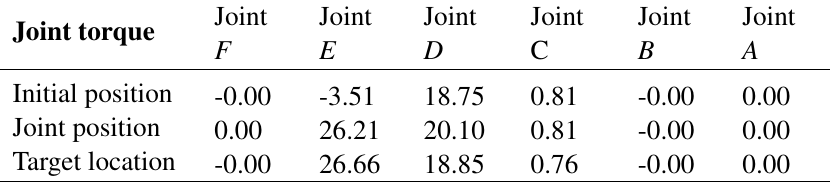
Table 2 Torque change value of UR5 robotic arm picking action (unit